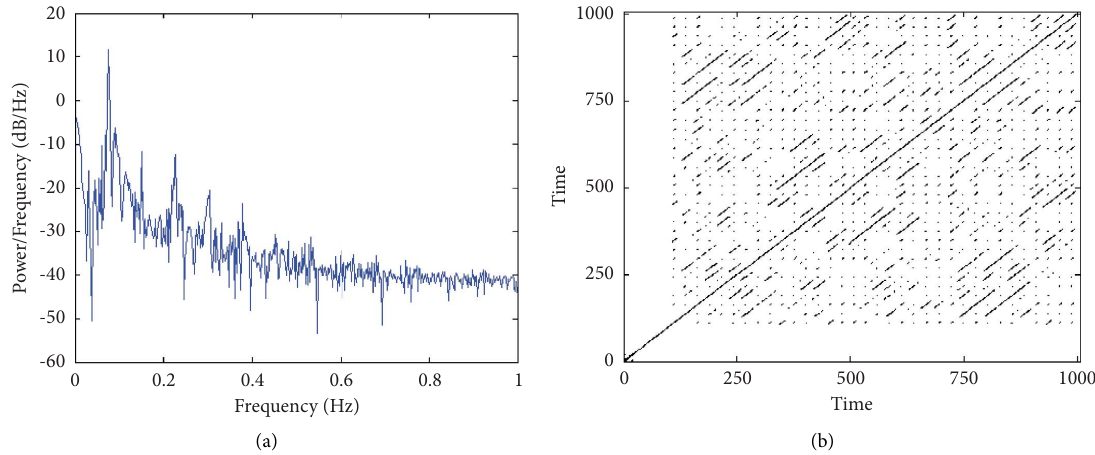
Figure 9: PSD and Recurrence plot of system (4).: (a) PSD and (b) Recurrence plot.